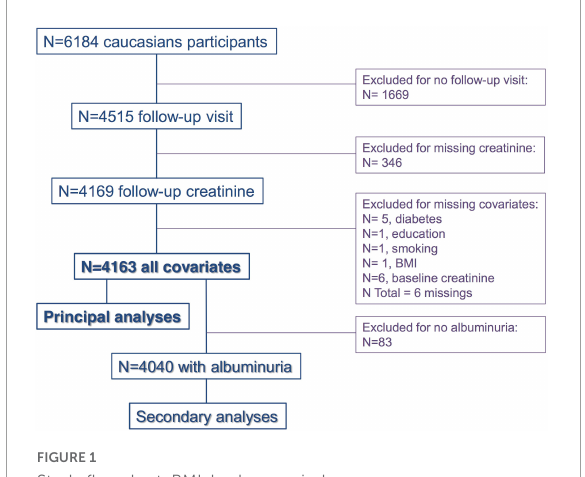
FIGURE1 Study flowchart. BMI, body mass index.